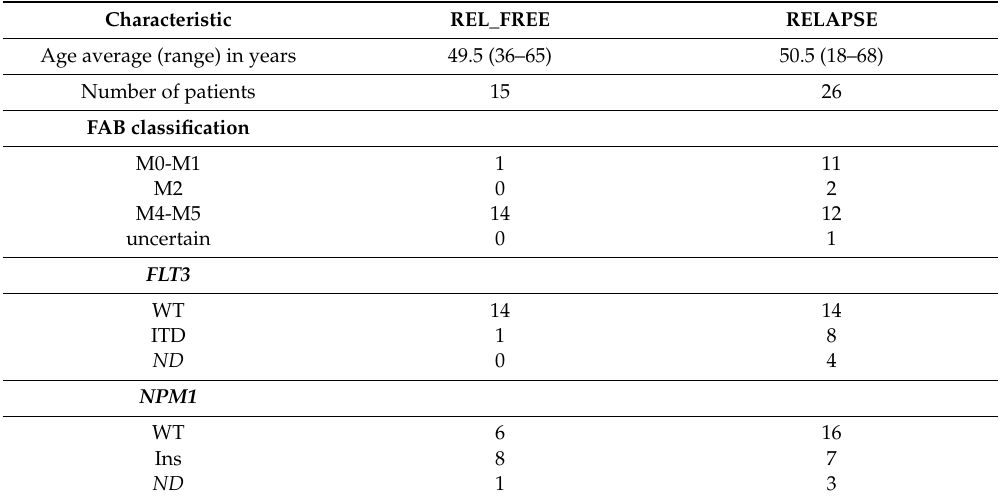
Table 1. Characteristics of the 41 AML patients used in the study at the first time of